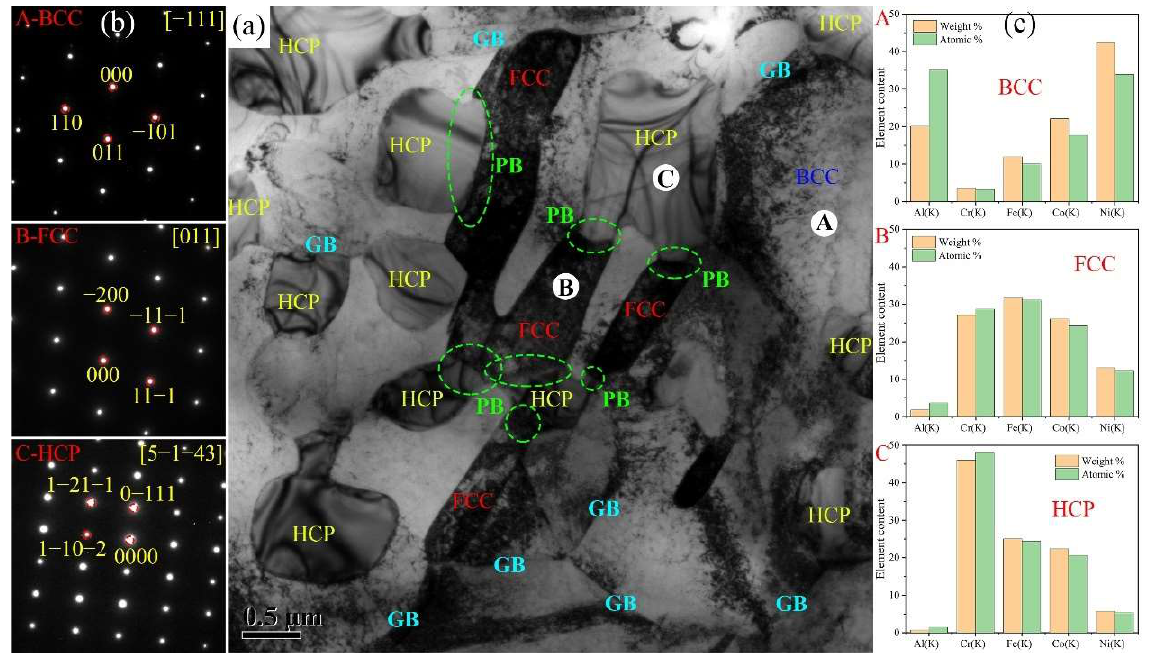
Figure 4. TEM analysis results of the AlCoCrFeNi components after 800 °C high-temperature treat- ment: ( a ) high-magnification electron images; ( b ) selected area diffraction patterns; ( c ) distribution of alloying elements.